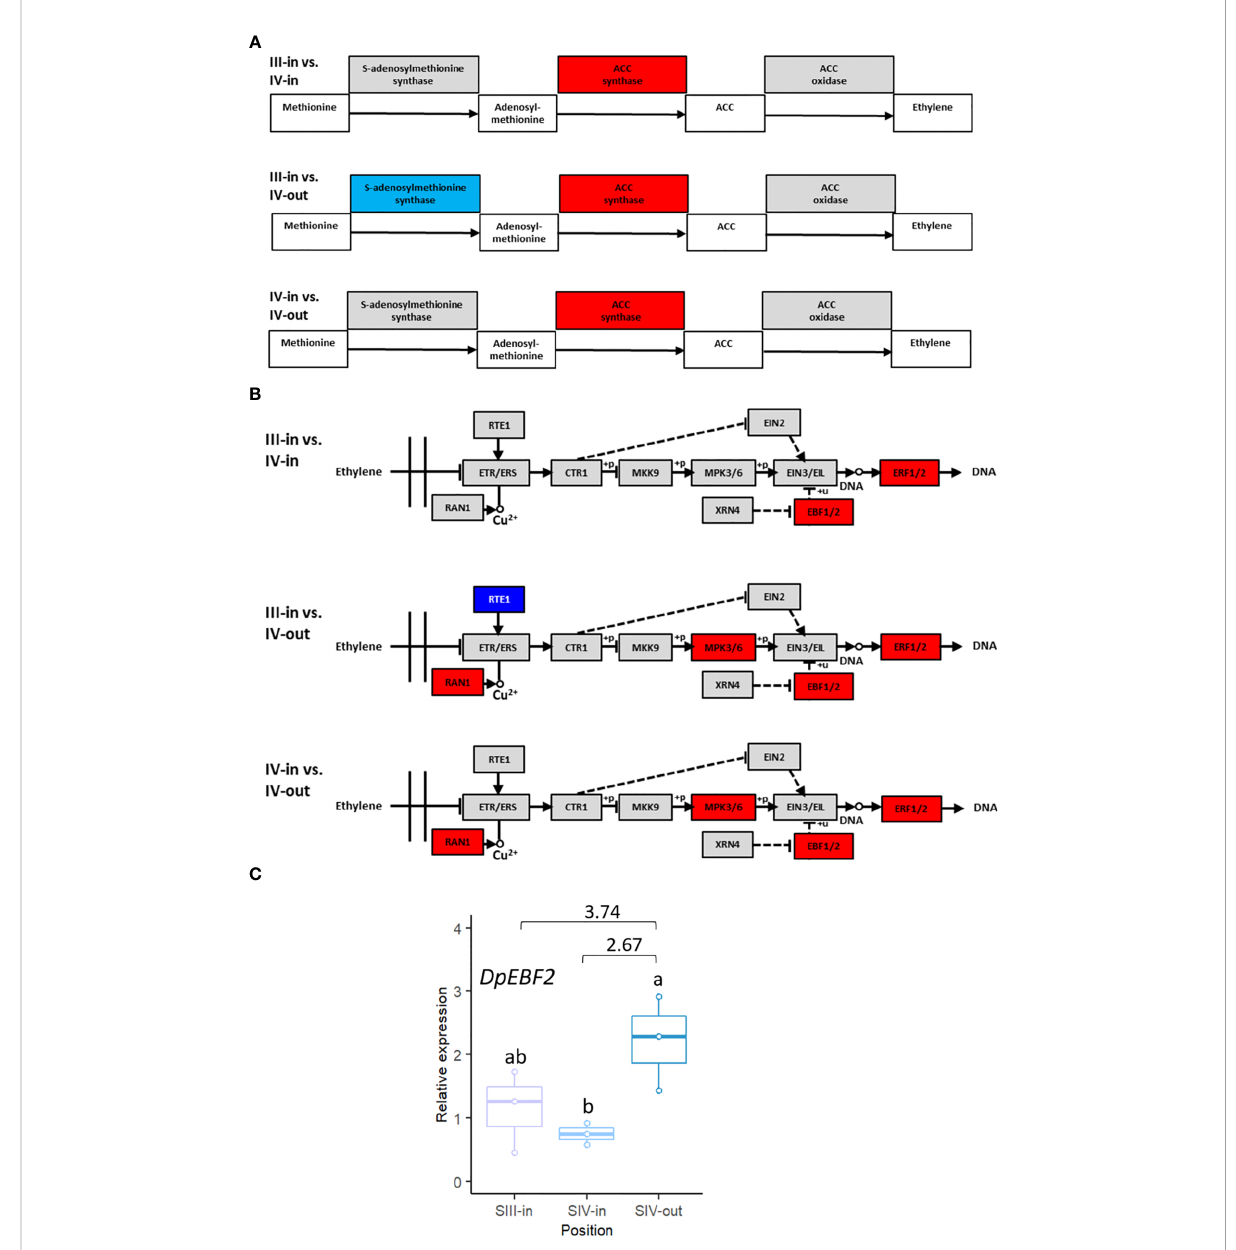
FIGURE 6 Changes in expression of dahlia fl oret genes associated with ethylene (A) biosynthesis (B) signal transduction pathway in comparisons between fl orets from: SIII-in vs. SIV-in, SIII-in vs. SIV-out and SIV-in vs. SIV-out (from KEGG analysis of RNAseq data, Kanehisa & Goto, 2000). Grey indicates no signi fi cant change in gene expression, red indicates signi fi cantly upregulated and blue indicates signi fi cantly downregulated ( p < 0.05) (C) RT-qPCR of DpEBF2 expression, n=3, different letters indicate signi fi cant differences p < 0.05, based on a 2-way ANOVA followed by a Tukey ’ s test or a Kruskall Wallis test followed by a Dunn ’ s post hoc test if the data did not fi t the normality and equal variance criteria required. RNA seq log2FC shown on